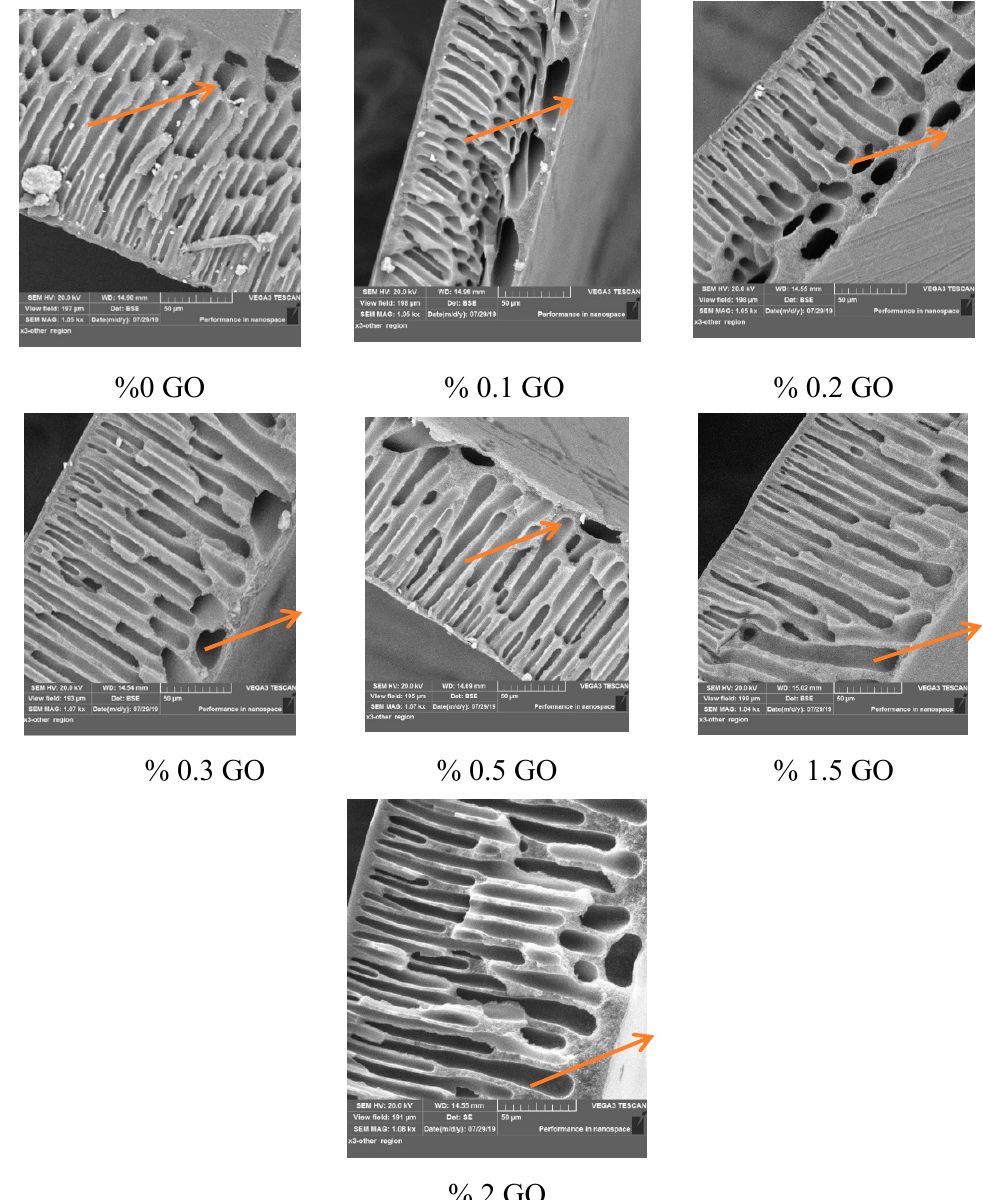
Figure 3. Cross-section SEM images of the control and GO-modified PES Figure 3. Cross ‐ section SEM images of the control and GO ‐ modified PES membranes. Table 2. Mean surface pore size and roughness for the top surface of the blend membranes.